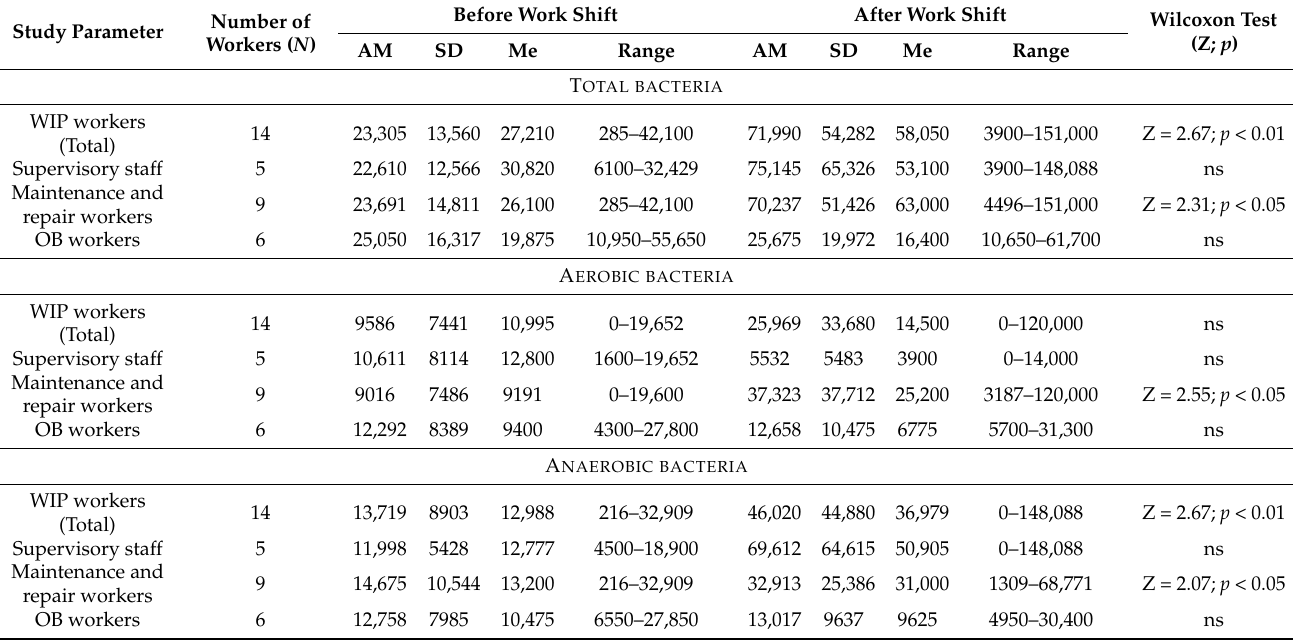
Table 2. Bacterial concentrations (CFU/mL) in the noses of WIP and OB workers throughout a work